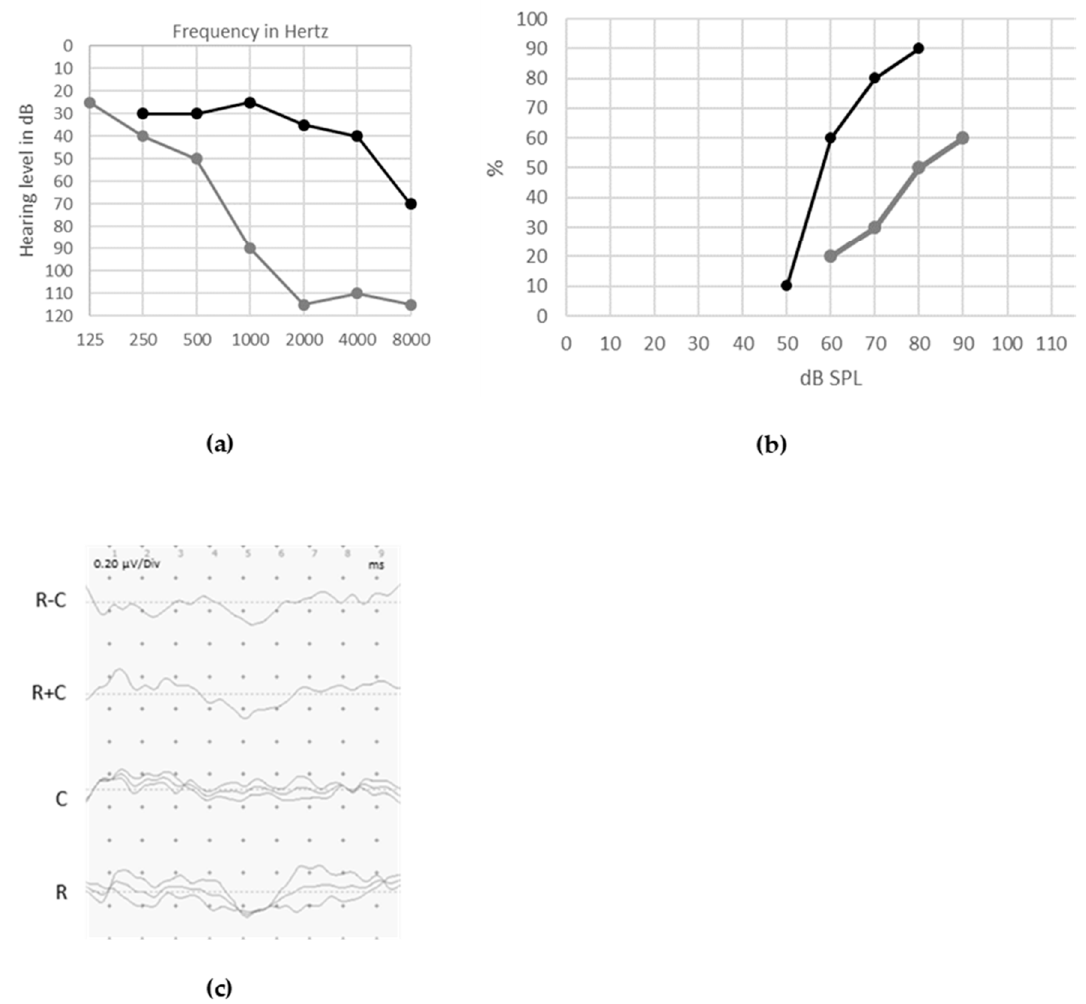
Figure 9. Audiological assessment in a 14-years-old male with auditory neuropathy spectrum disorder (ANSD). His medical history includes neonatal hyperbilirubinemia and low birth weight. Despite early hearing aids fitting, speech development was delayed. He shows residual pure-tone hearing thresholds (( a ), gray line) and poor speech discrimination (( b ), gray line) in the left ear. After left-ear cochlear implantation, aided tonal (( a ), black line) and speech (( b ), black line) thresholds show good auditory outcomes. Auditory brainstem responses (ABRs) at left ear are absent ( c ). However, speech perception in noise, such as during school activities, remains poor.